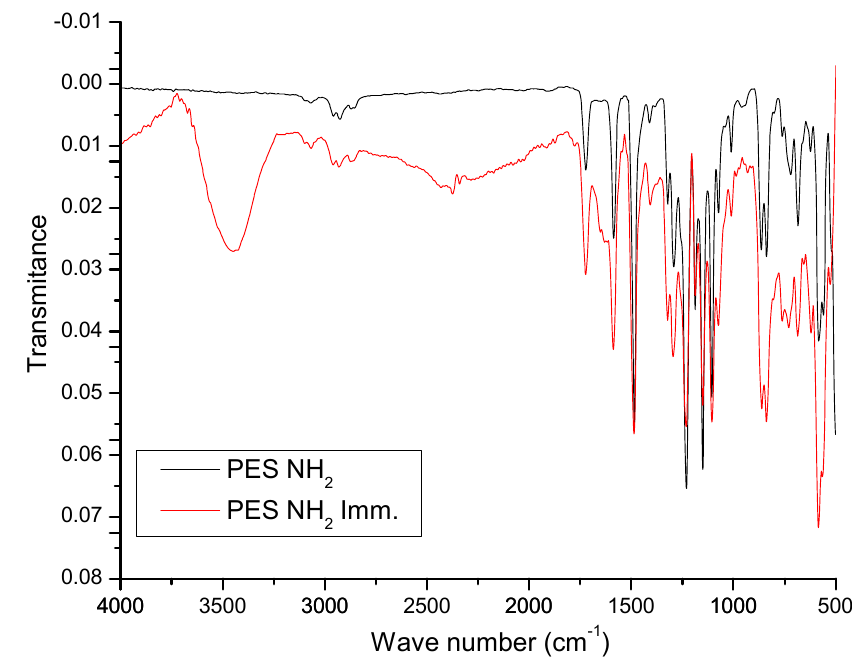
and lipases immobilized onto PES–NH 2 and the red line is spectra of lipase immobilized onto PES–NH 2